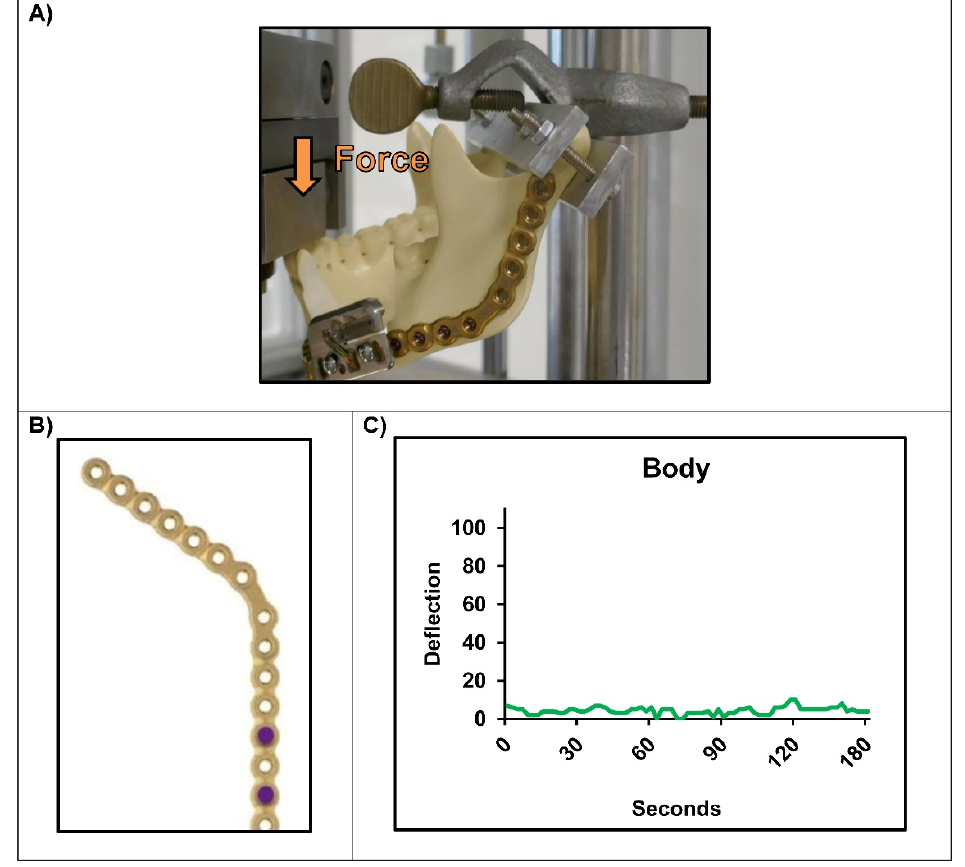
Figure 5. Simulation of the mounted strain measurement device on an artificial defect in the mandibular body (displacement 1.5 mm; f = 0.5 Hz; no defined force): ( A ) Mounted sensor to the mandible; ( B ) Used holes for fixation of the device; ( C ) No registration of the sinusoidal force being applied to the incisors.